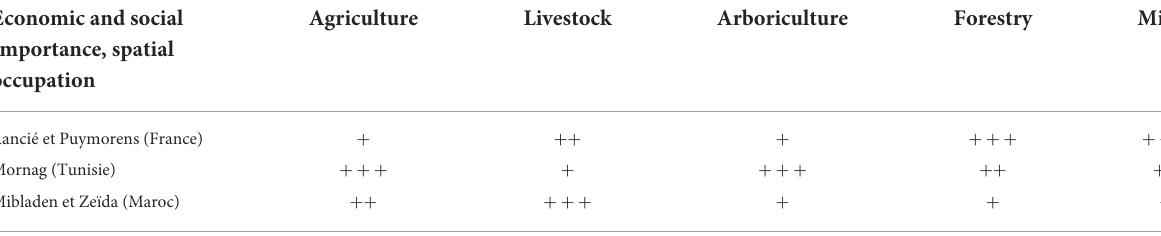
TABLE 1 Brief relative comparison between the three sites’ activities and